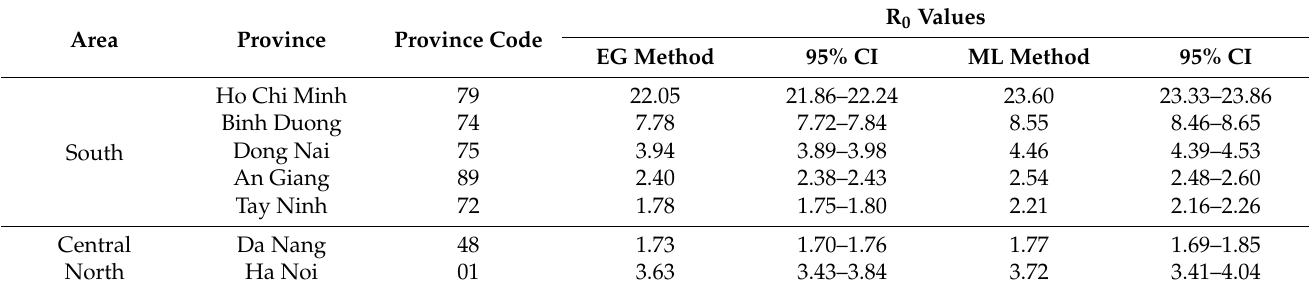
Table 2. R 0 values of COVID-19 at the province level in the fourth wave of the pandemic in Vietnam.